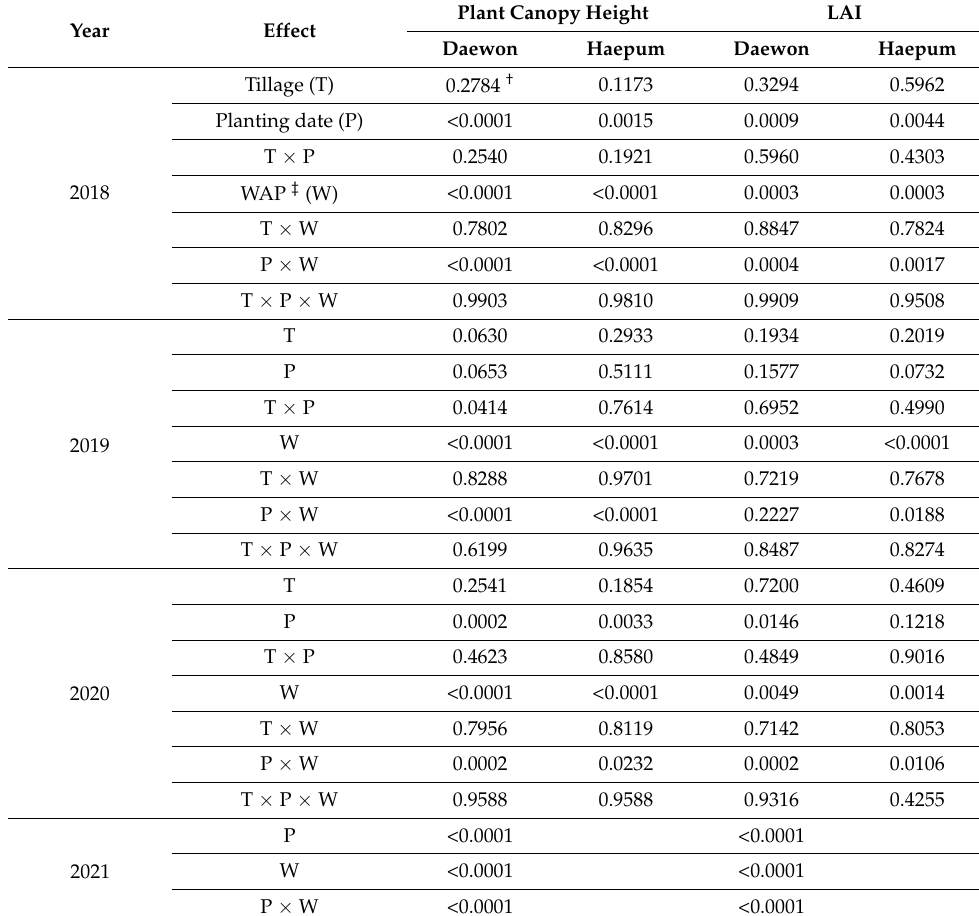
Table 5. Source of variation and probability level of plant canopy height and LAI of two soybean cultivars (Daewon and Haepum) over 4 years.